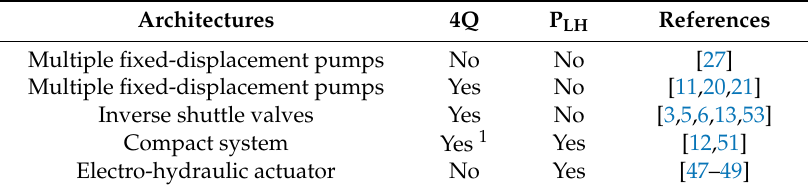
Table 2. Self-contained cylinders: concepts and characteristics.